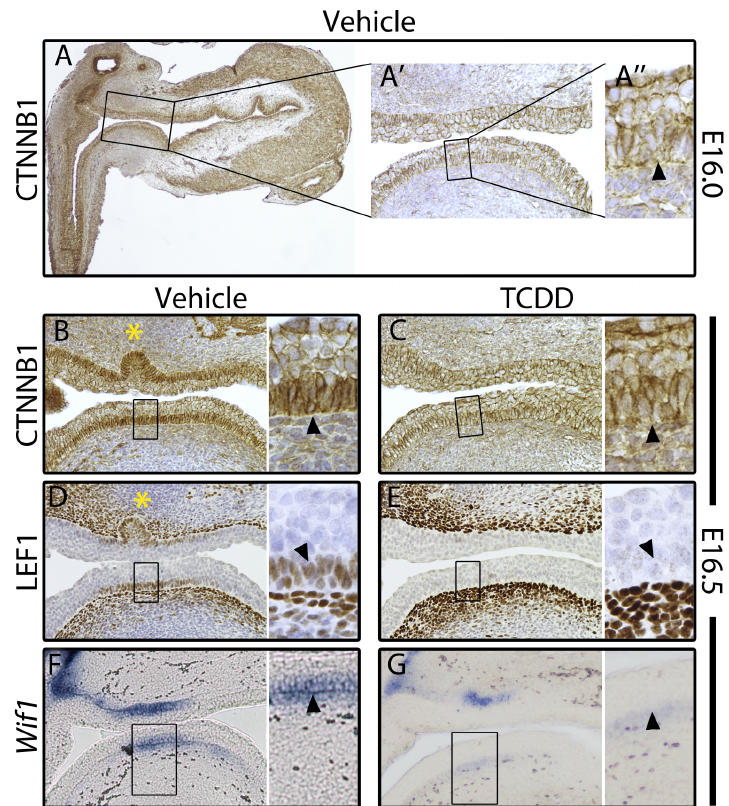
expression in ventral basal epithelial cells of E16.5 TCDD-exposed UGSs resembled that of E16.0 UGSs with little to no detectable CTNNB1 in the cytoplasm or nucleus (Figure 3C). These data show that during normal development, the canonical Wnt signaling cascade is initially activated in basal epithelial cells of the ventral UGS around E16.5, just prior to the initiation of ventral budding, and that in utero exposure to TCDD blocks this activation (Tables 1,2). Figure 3. TCDD-induced activation of AHR signaling prevented activation of canonical Wnt signaling in the ventral UGE of male C57BL/6J mouse embryos. Dams were dosed on E15.5 with corn oil vehicle (5 mL/kg, po) or TCDD (5 μ g/kg, po). Images are representative sagittal sections from vehicle-exposed ( A , B , D , F ) or TCDD-exposed ( C , E , G ) UGSs stained by IHC ( A – E , brown stain) or ISH ( F – G , purple stain). ( A ) At E16.0 in both control and TCDD-exposed UGSs, CTNNB1 expression was restricted to cell membranes in the UGE. ( B ) By E16.5 in control UGSs, CTNNB1 had accumulated in the cytoplasm and translocated into the nucleus of ventral basal epithelial cells. ( D , F ) CTNNB1 target genes Lef1 ( D ) and Wif1 ( F ) were also expressed in the ventral basal epithelial cells of E16.5 control UGSs, demonstrating functionally active CTNNB1 signaling. ( C ) At E16.5 in TCDD-exposed UGSs, CTNNB1 did not accumulate in the cytoplasm, and was not detected in the nucleus of ventral basal epithelial cells. ( E , G ) Neither Lef1 nor Wif1 was expressed in ventral basal epithelial cells, confirming there is no active CTNNB1 signaling in the ventral epithelium of TCDD-exposed UGSs. Arrowheads point to basal epithelial cells; yellow asterisks mark prostatic buds. Adapted from [152] with permission from Oxford University Press, copyright